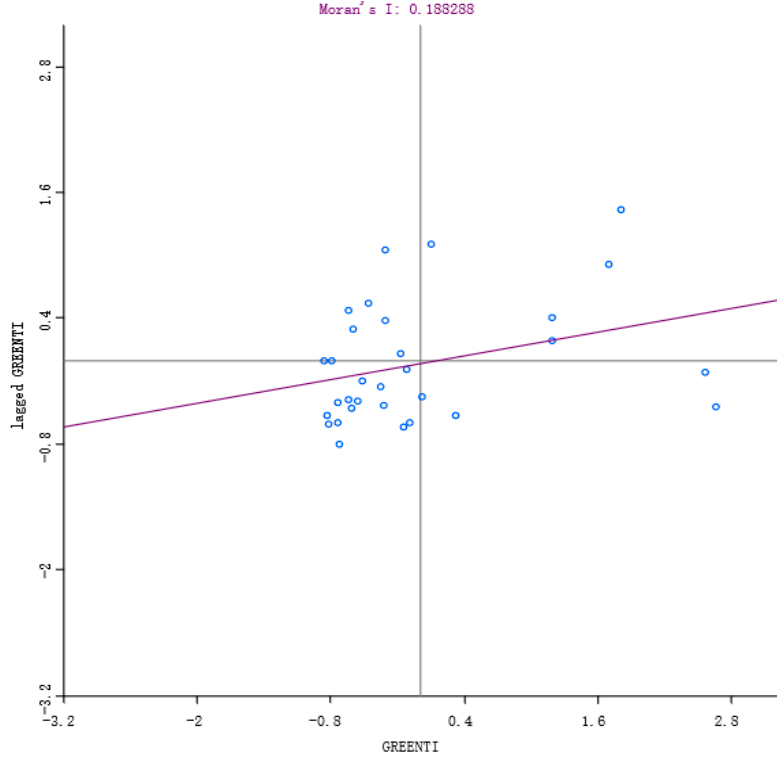
Figure 2. Scatter diagram of Moran’s I in 2007.